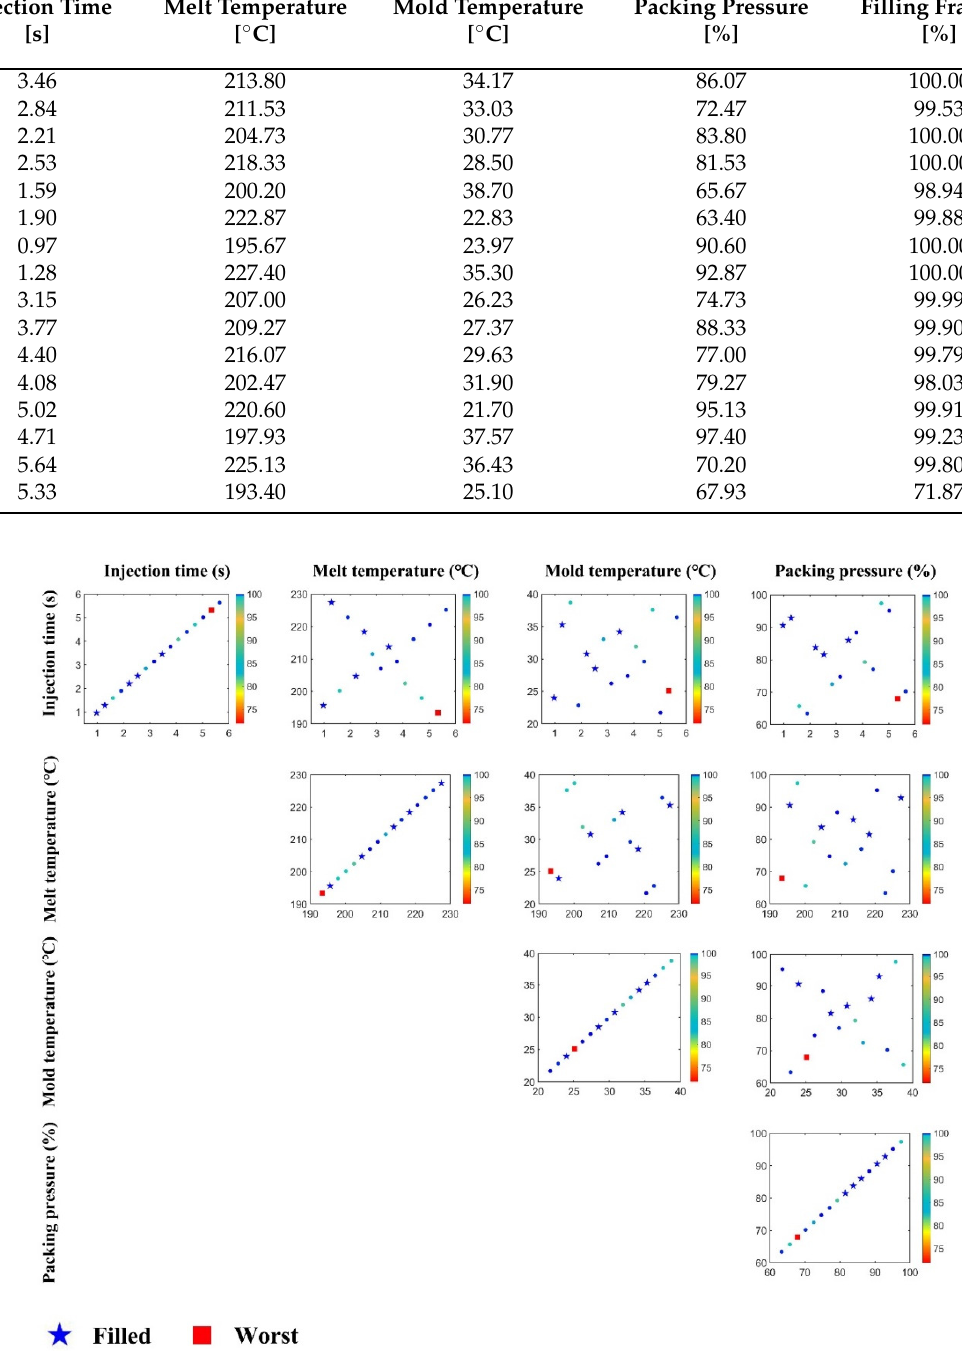
Figure 14. Combination plots of OLHS. Each subfigure is a scatter plot of two parameters. All filling fraction results of the OLHS samples are distributed in these two-parameter spaces.